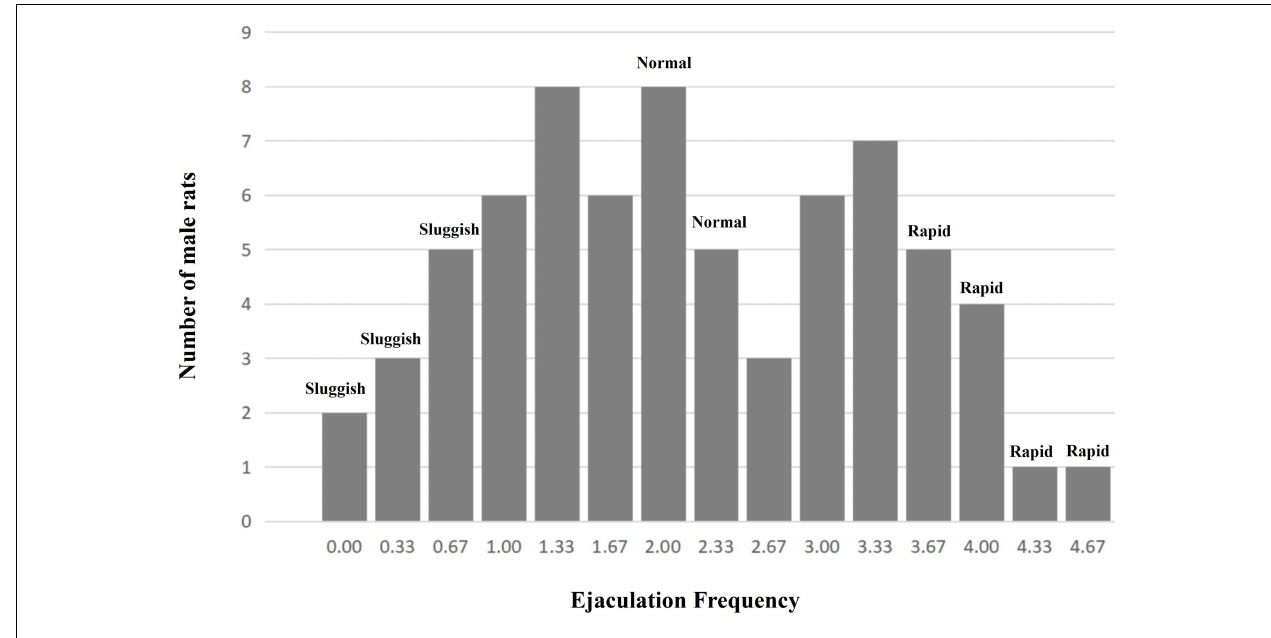
FIGURE 1 | The number of premature ejaculation rats in different groups. TABLE 1 | Sexual behavioral parameters of the male rats in different groups. Behavioral